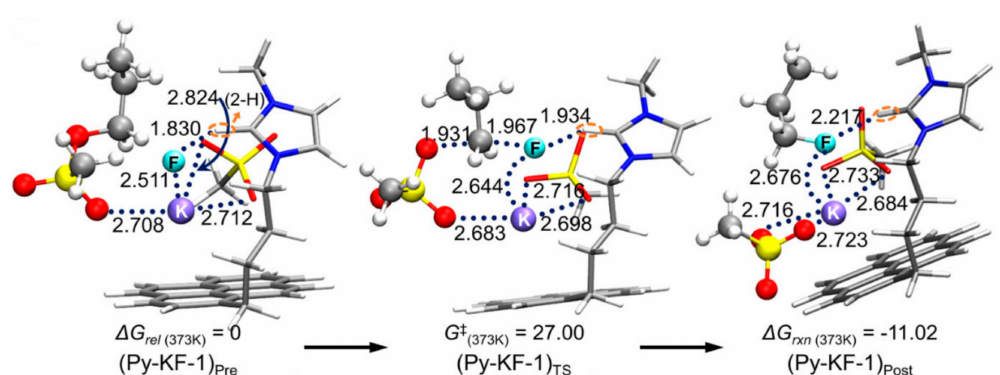
Figure 4. S N 2 fluorination in pyrene-tagged IL.